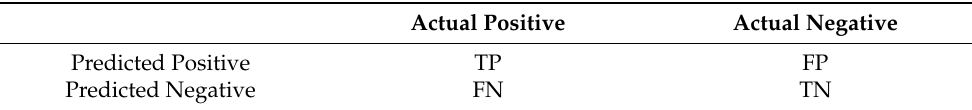
Table 4. Confusion